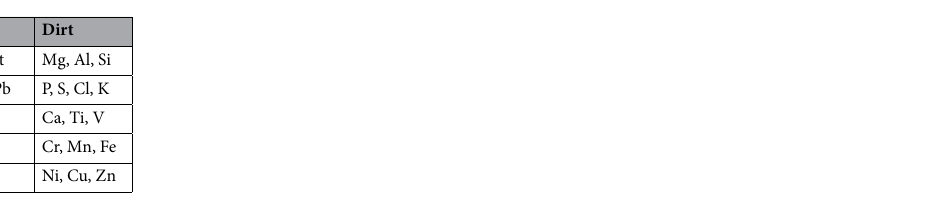
Table 1. Elements identified by XRF analysis divided between metallic alloy and